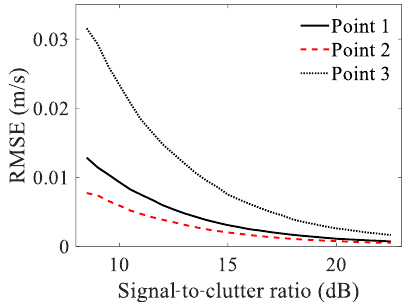
Figure 5. RMSE of velocity estimation with SCR of 8–23 dB.